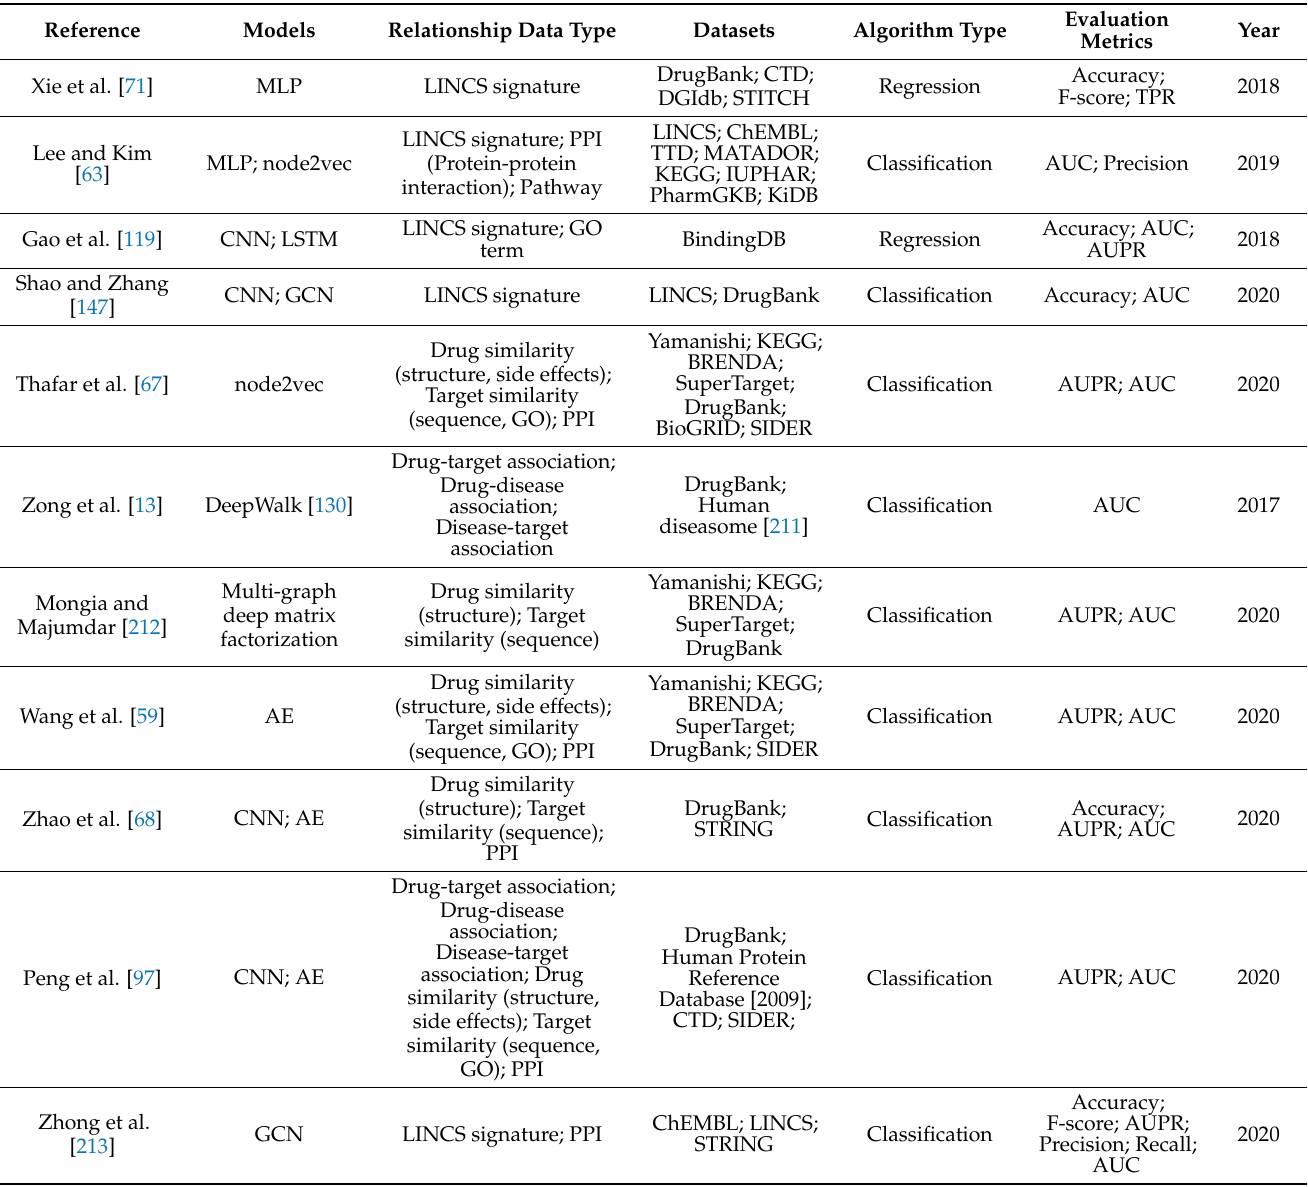
Table A3. Relationship-based DL methods for DTI